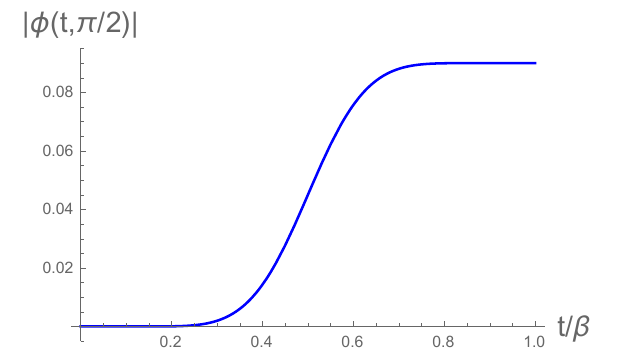
Figure 9 . (cid:26) b ( t ) for the quench pro(cid:12)le (3.1) at (cid:15) = 0 : 09.